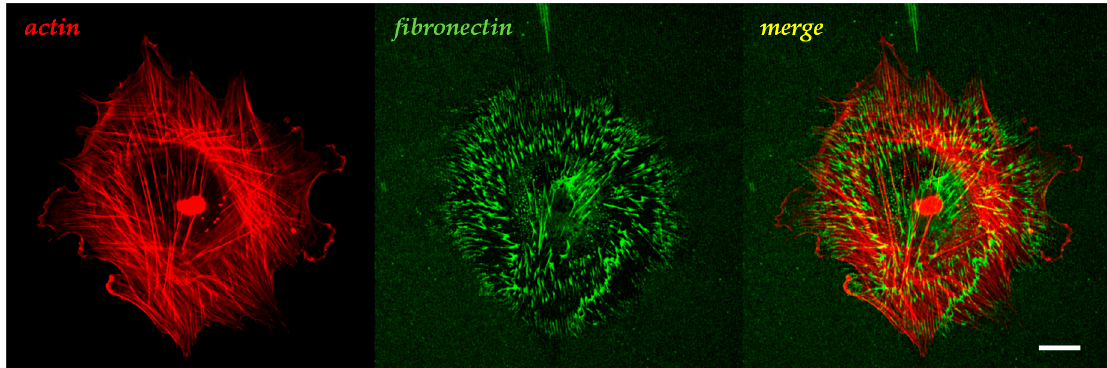
Figure 1. Confocal micrograph showing the effect of cell-generated forces on physisorbed fibronectin. MC3T3 preosteoblasts cultivated for 12 h on a nanograted, O2 plasma-treated PDMS substrate. Fibronectin (10 µm/mL) undergoes extensive remodelling caused by contractile forces. Fibronectin compaction is observed at both ends of actin fibers. Note how fibronectin smears follow the actin direction and leave a dark halo upon compaction. Actin is stained with Tetramethylrhodamine B isothiocyanate-phalloidin (red); fibronectin is stained by immunofluorescence (green). Scale bar: 20 µm.